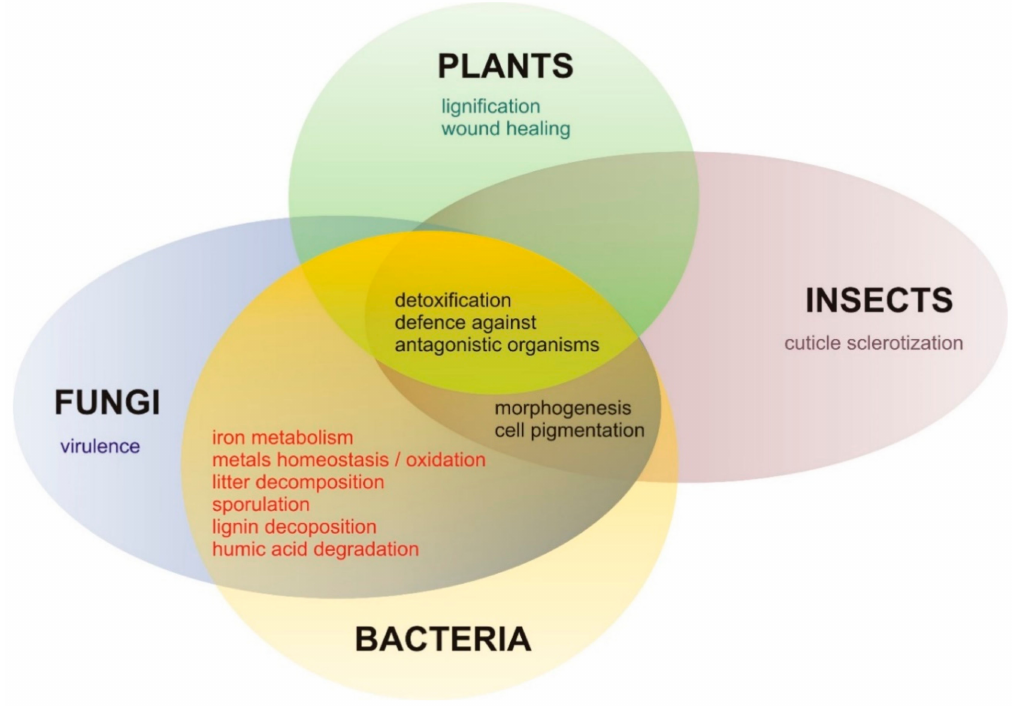
Figure 4. Comparison of laccase biological functions in di ff erent organisms. The protective role is common for all taxonomic groups and, most likely, it is the primary role of laccases in all living organisms. Other functions are most probably the result of specialization of this enzyme, which narrows its substrate